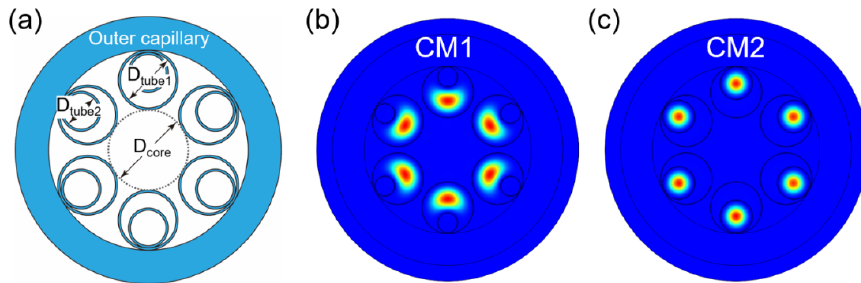
Figure 4. ( a ) Geometry of a nested antiresonant fiber (NANF) with six nested tubes, ( b ) the mode pattern of cladding mode CM1, and ( c ) the mode pattern of cladding mode CM2.